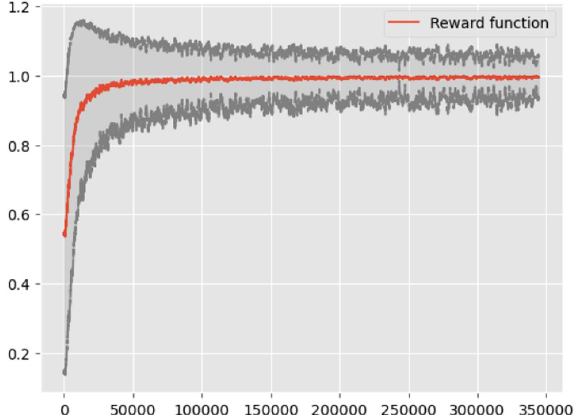
Fig. 4 Performance of the contextual stochastic charging agent in terms of the expected reward function. The variance bounds are set at ± σ distance from the mean reward